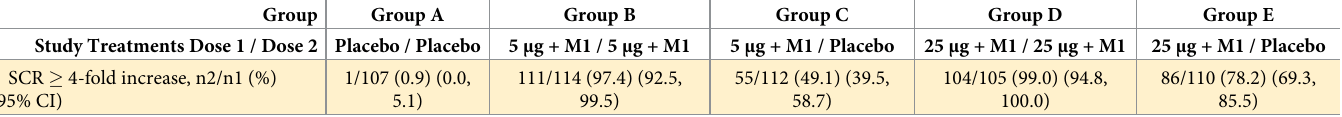
tive to older participants. Anti-spike IgG immune responses were similar for Groups B and